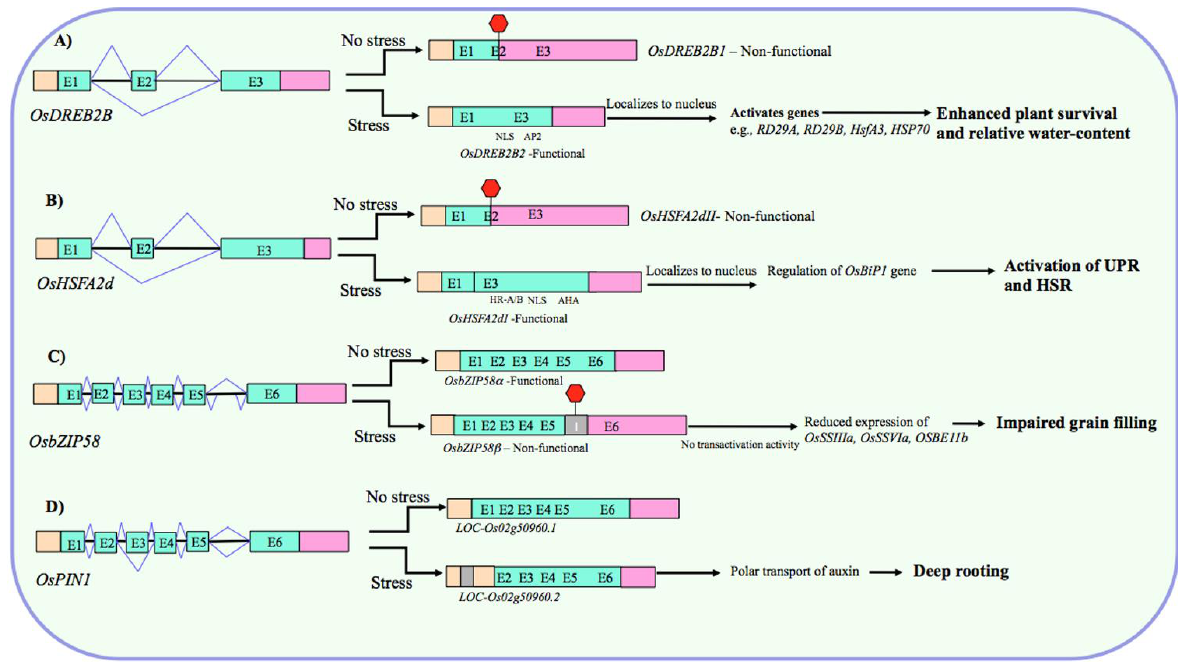
Figure 2. Representative examples of AS-mediated regulation of gene expression in rice under heat/drought stress conditions. ( A ) Under nonstress conditions, nonfunctional (due to frameshift and PTC) form predominates, while the functional form (with intact NLS and typical AP2/ERF domain) is produced under drought to increase drought tolerance potentially by enhancing the expression of stress-related genes [70]. ( B ) Under nonstress conditions, nonfunctional (due to PTC) form predominates, while the functional form (with intact DNA-binding-, oligomerization-, and activation-domains) is produced under heat stress which participated in heat stress response (HSR) by regulating the expression of unfolded protein response (UPR) marker gene OsBip1 [72]. ( C ) Under nonstress conditions, functional form predominates, while the nonfunctional form (due to IR-mediated PTC), lacking bZIP domain, is produced predominantly under high temperature, which causes impaired grain filling by repressing the expression of genes associated with grain filling [76]. ( D ) An IR event in the OsPIN1 transcript has a potential functional significance in regulating the rice deep rooting under drought by facilitating the polar auxin transport [68]. Boxes and lines represent exons and introns, respectively. In transcripts, peach, aquamarine, and violet colors represent 5 (cid:48) -UTR, coding region, and 3 (cid:48) -UTR, respectively. Red hexagons represent PTC. “I” in the splice isoforms indicates an intron retention